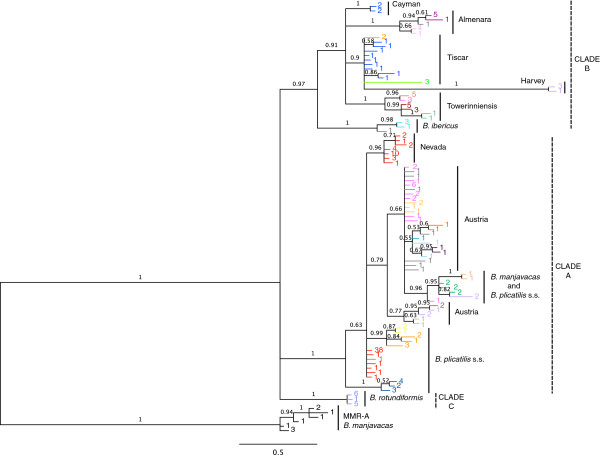
Bayesian trees of mmr-b full repeat coding sequences. Posterior probabilities are shown along the branches. Numbers at the tip of each branch indicate the number of identical repeats represented by that branch; colors are the same as in Figure 
1. Phylotype and major clade designations are shown to the right.